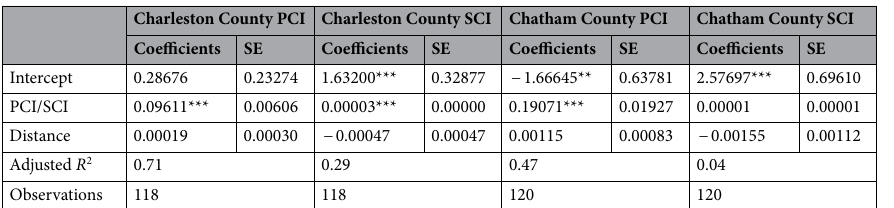
Table 4. Regression results for the number of evacuated users in the destination counties (dependent variable) and PCI (or SCI) of the county pairs between evacuation county and each of the destination counties. * p < 0.1, ** p < 0.05, *** p <